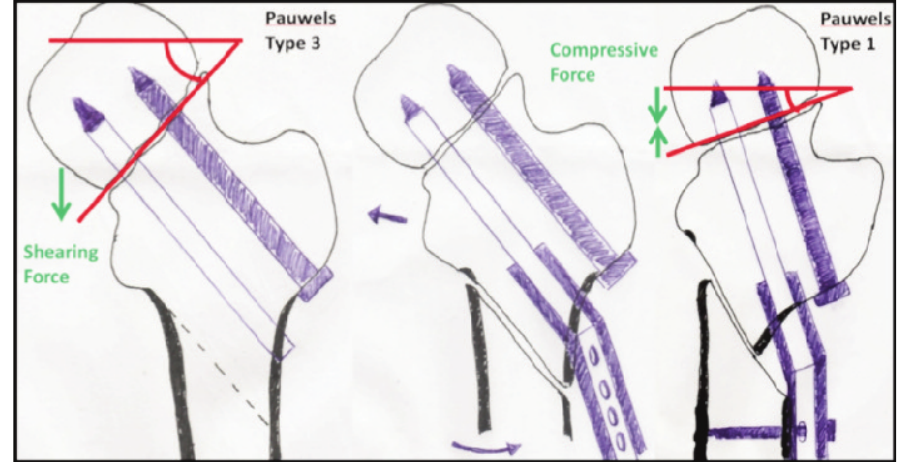
Schematic drawing (from left to right) of valgus sliding subtrochanteric osteotomy and Pauwels angle correction. Dynamic hip Fig. 3: screw and derotation screw insertion along the axis of femoral neck, and oblique osteotomy done directed towards the lesser trochanter. The degree of obliquity depends on neck shaft angle. The distal mobile fragment is clamped to barrel plate to achieve the desired correction via lateralisation of the femoral shaft. The Pauwels angle becomes more horizontal after neck shaft angle corrected to barrel plate angle. This technique allows translation only in frontal plane without altering the femoral neck